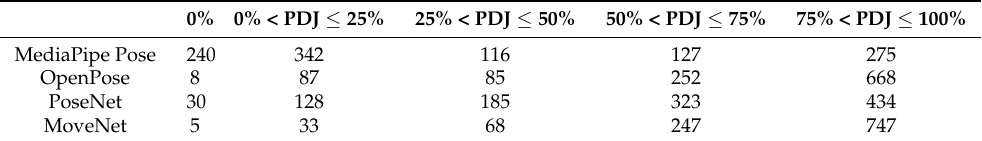
Table 4. Number of images recognized by each HPE library in each specific range of PDJ